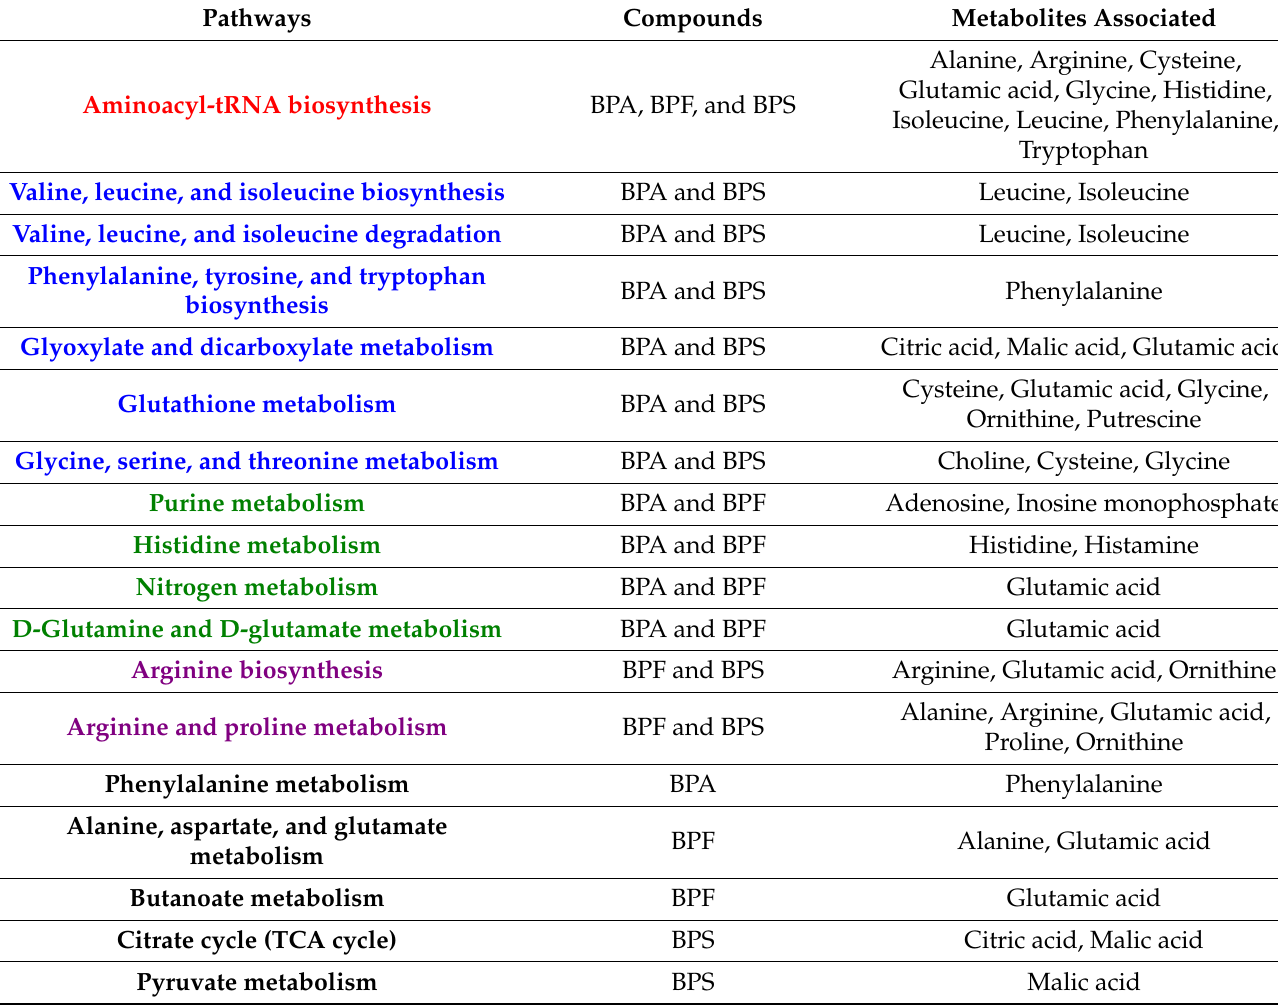
Table 1. MetaboAnalyst evaluation for major biochemical pathways impacted by bisphenol exposure ( p ≤ 0.05). Pathway in red : common to all three bisphenols (1). Pathways in blue : common between BPA and BPS (6). Pathways in green : common between BPA and BPF (4). Pathways in purple : common between BPF and BPS (2). Pathways in black —unique